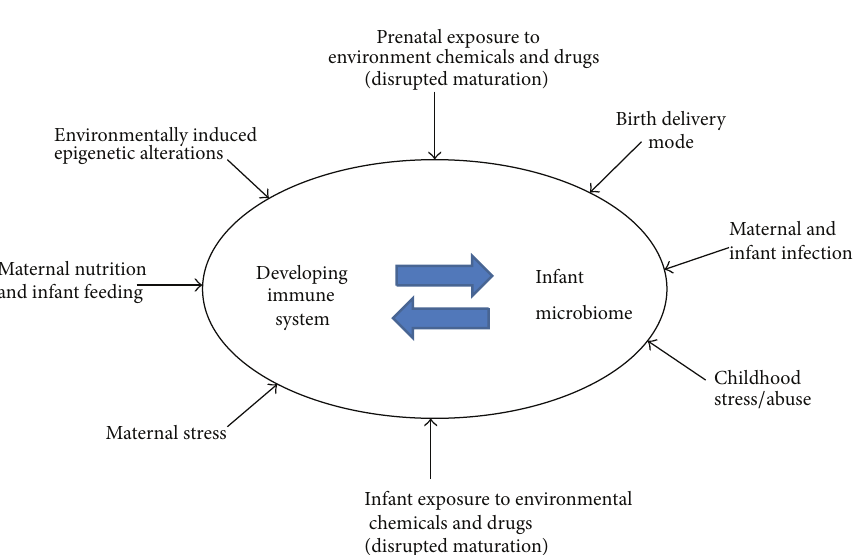
Figure 1: This figure depicts a model following the “Completed Self” paradigm [91] in which the immune system and infant microbiome need to comature without interference or disruption to reduce later-life health risks. The categories of environmental risk factors reported to cause prenatal and/or postnatal disruption are